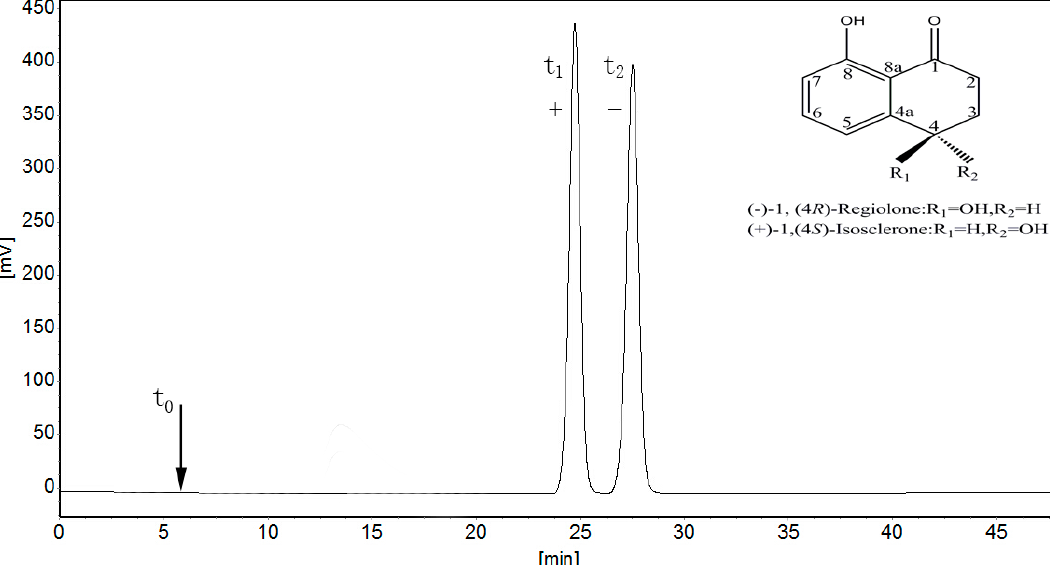
Figure 1. The elution order of 4,8-DHT enantiomers. Conditions : mobile phase, n -hexane/iso-propanol/AA (95:5:0.1, v / v /%); flow rate, 0.8 mL·min − 1 ; column temperature, 20 °C.